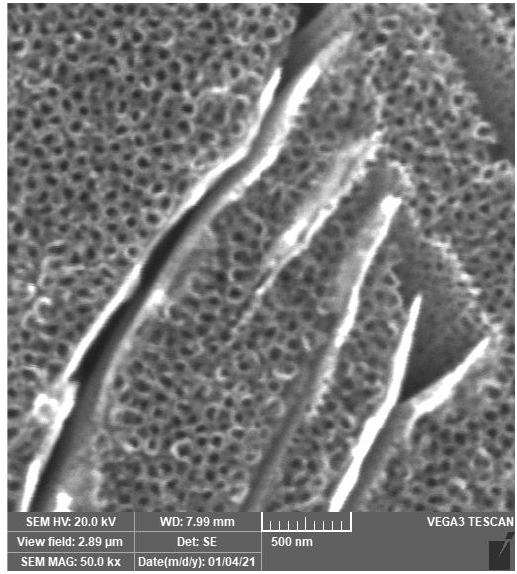
Figure 1. The nanostructured surface of Ti-6Al-4V prepared by anodic oxidation.